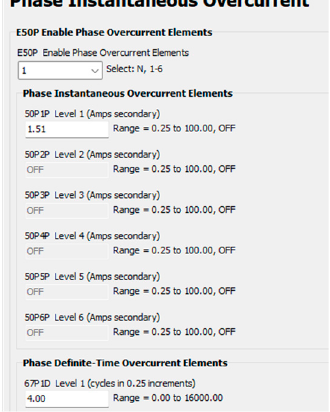
Figure 5. Setting 50P1P and 67P1D level for R1.